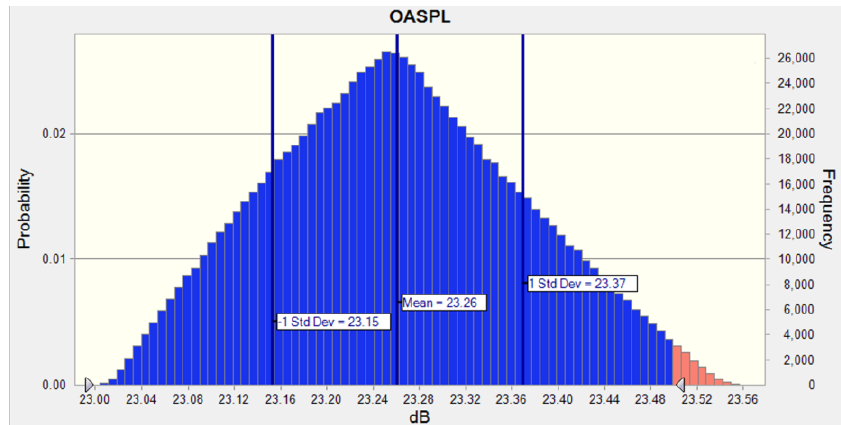
Figure 17. Performance distribution of probability triangular distribution for OASPL.